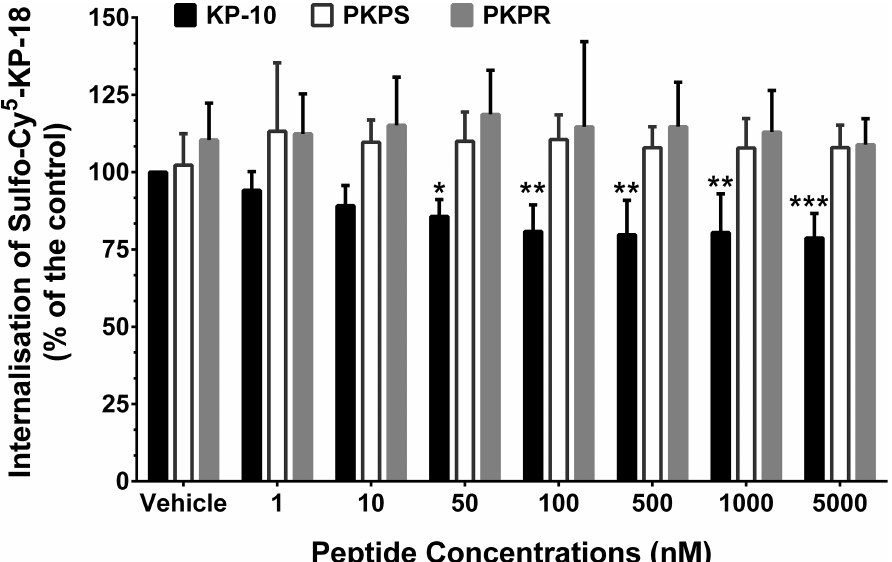
Fig 6. Effect of KP phosphinic peptides on Sulfo-Cy 5 -KP-18-induced internalisation of kisspeptin receptor. MCF- 7 cells transiently expressing kisspeptin receptor were co-incubated with 50 nM of Sulfo-Cy 5 -KP-18 and vehicle (control), different concentrations of KP-10 (black bars), PKPS (white bars) or PKPR (grey bars) respectively for 30 minutes. The internalisation of Sulfo-Cy 5 -KP-18 was normalised as percentage of that (control) measured in the absence of KP-10 (vehicle only). The data represent the mean percentage-changes of four independent experiments. (cid:3) , P < 0.05; (cid:3)(cid:3) , P < 0.01; (cid:3)(cid:3)(cid:3) , P < 0.005, compared with the control.